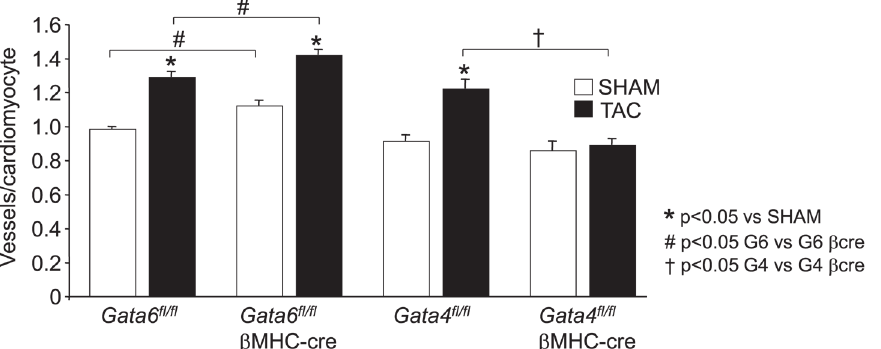
Figure 3. Cardiac-specific deletion of Gata4 but not Gata6 prevents compensatory angiogenesis in the hearts of mice. The graph shows immunohistological quantitation of capillaries in the left ventricle normalized to surrounding cardiomyocytes in the indicated groups of mice. TAC was performed for 2 weeks. Mice were 10–12 weeks of age at harvesting. Hearts from at least 4 mice were analyzed in each group. *P , 0.05 versus Gata6 fl/fl or Gata4 fl/fl sham. doi:10.1371/journal.pone.0084591.g003 PLOS ONE |